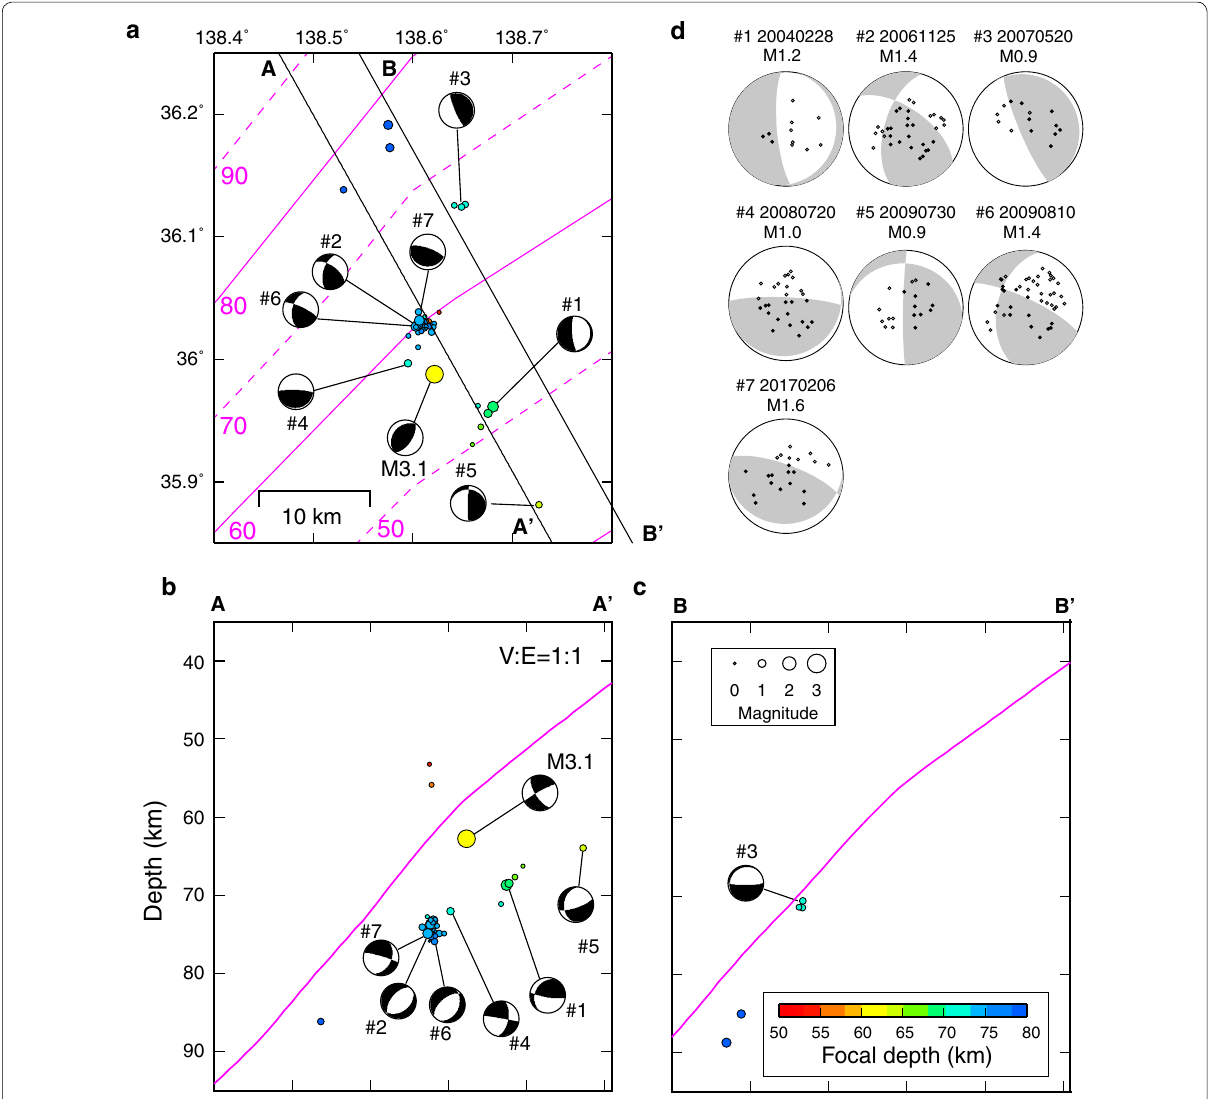
Fig. 5 a Map showing the distribution of 40 earthquakes relocated with hypoDD (see text for procedural details). Available earthquake focal mech- anisms (#1–#7 and M3.1 earthquake) are shown in equal-area lower-hemisphere projections. Two lines, A–A’ and B–B’, are profiles along which cross sections are shown in b and c , respectively. b Vertical cross section of earthquakes along line A–A’, showing events within 3 km of the line. c As for b , but for line B–B’. d Focal mechanism solutions of seven earthquakes (#1–#7) determined in this study. Filled and open circles indicate compressional and dilatational first motions, respectively. Magnitudes of earthquakes are shown above their respective beach ball